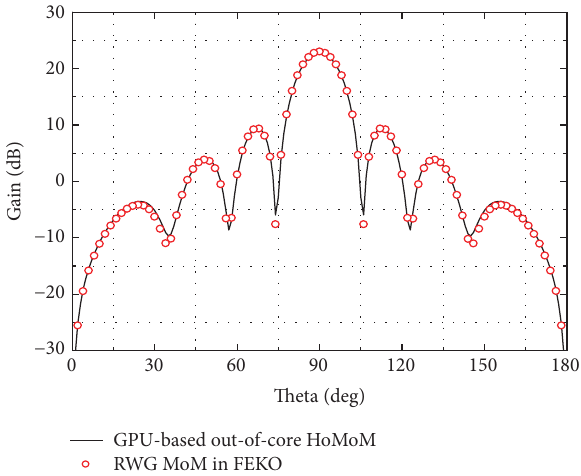
Figure 14: 2D results of the microstrip phased array in xoz